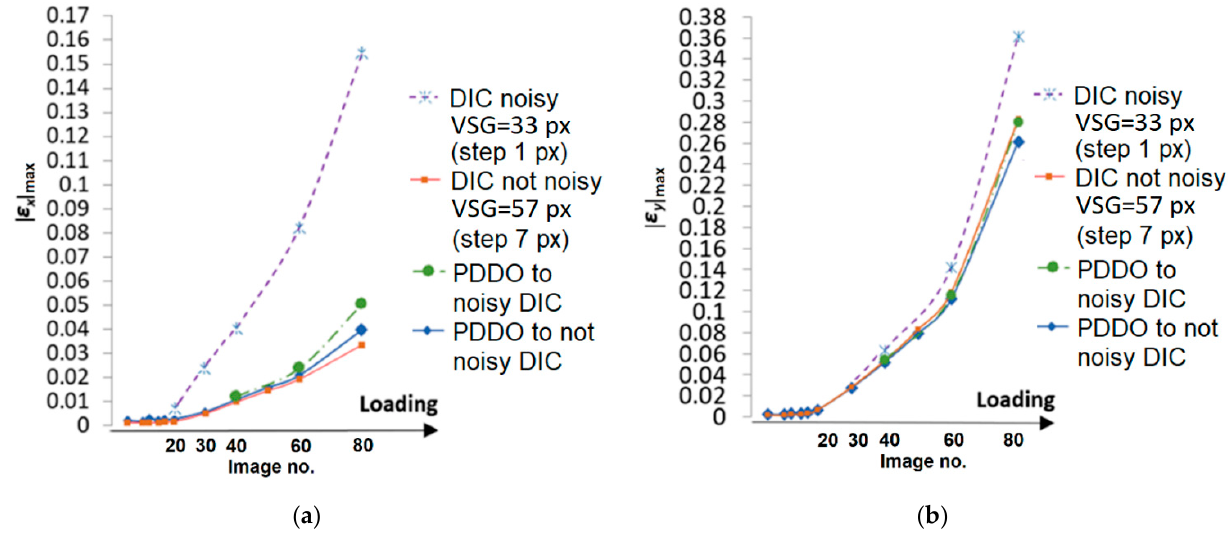
Figure 14. Effect of the input noise on the calculated strains at different levels of deformation: ( a ) ε x strains, ( b ) ε y strains.